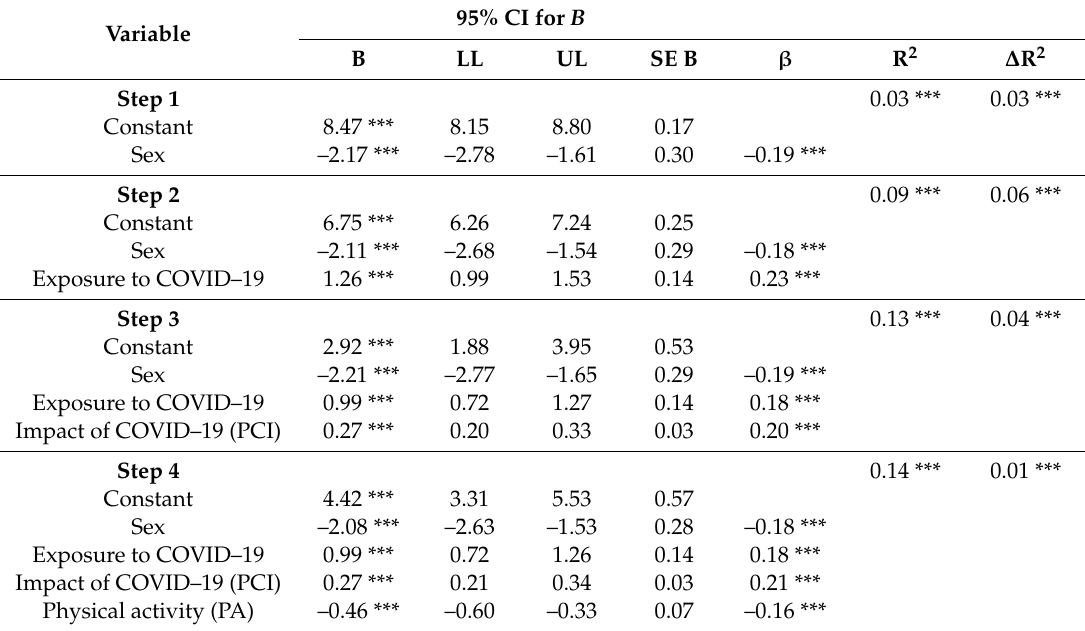
Table 6. Hierarchical regression results for